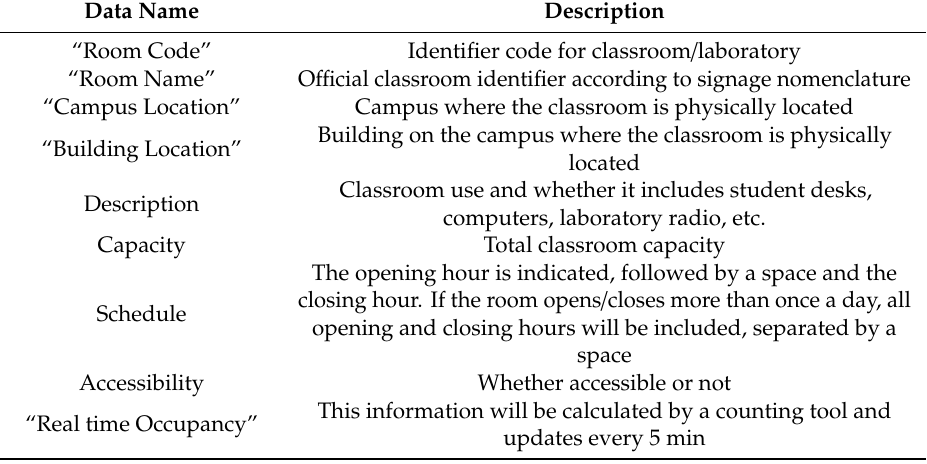
Table 1. University Spaces Data Set.